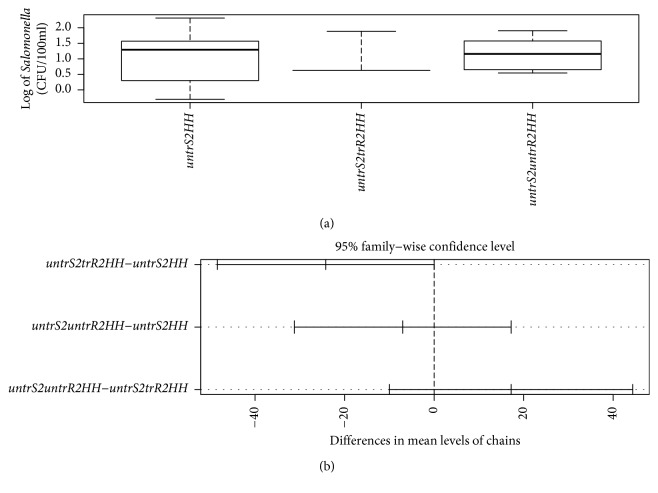
Boxplot (a) and pairwise comparison (b) of Salmonella typhi counts (CFU/100 mls) in water-handling chains (untrS2HH = untreated source to households; untrS2trR2HH = untreated source to treated reservoir to households; untrS2untrR2HH = untreated source to untreated reservoir to households).